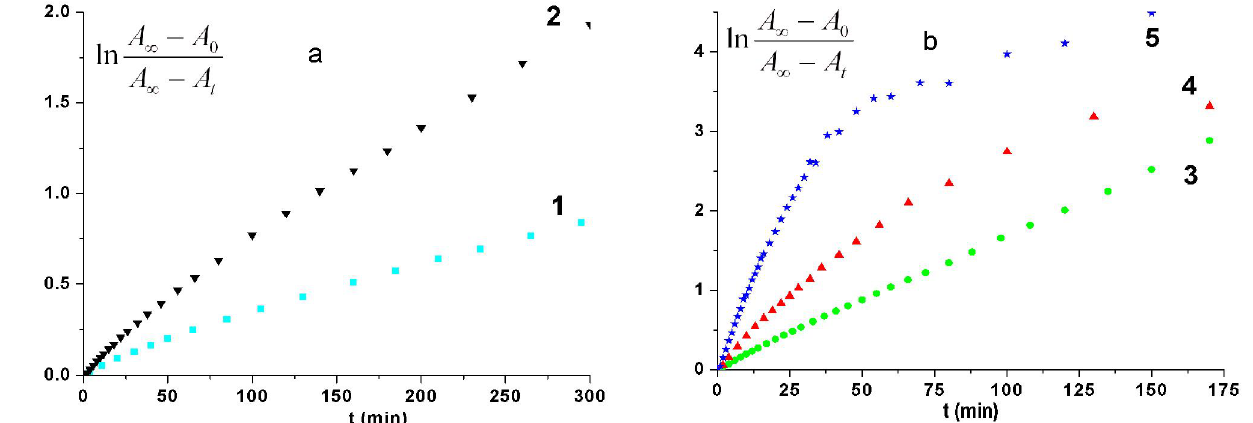
Figure 9. Kinetic data for cis-trans thermal recovery of azo polymer PTEI in DMF